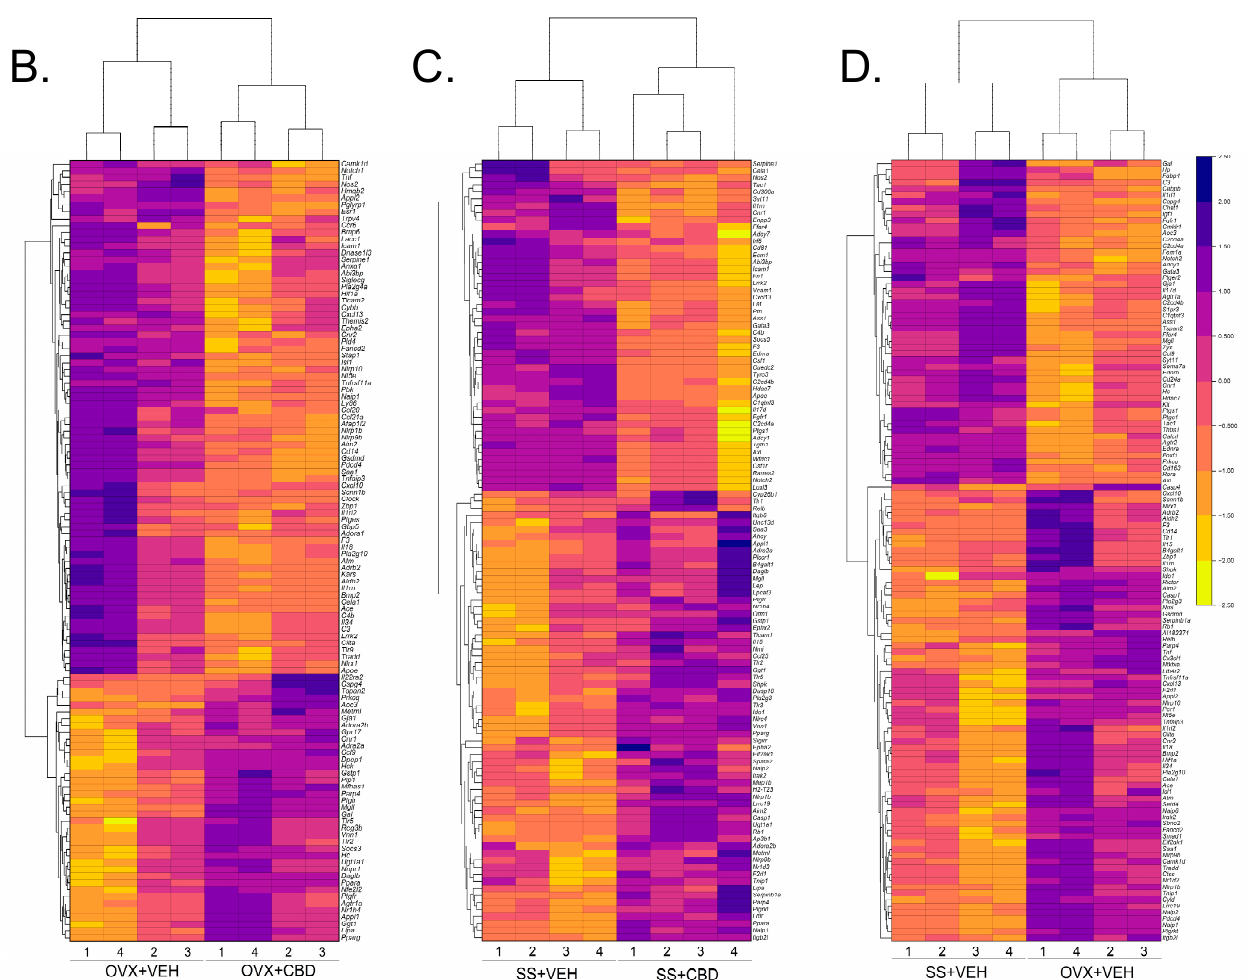
Figure 1. Differentially expressed inflammatory response genes. ( A ) Venn diagram showing the DEGs for each of the indicated comparisons as well as DEGs that are in common between comparisons. DEGs held in common do not necessarily indicate the same direction of change. DEGs for ( B ) OVX+VEH vs. OVX+CBD, ( C ) SS+VEH vs. SS+CBD, and ( D ) SS+VEH vs. OVX+VEH generated based on Euclidean clustering. Z-score scale indicates downregulated genes from 0 to − 2.5 (orange to yellow shades) and upregulated genes from 0 to 2.5 (red to purple/navy shades).